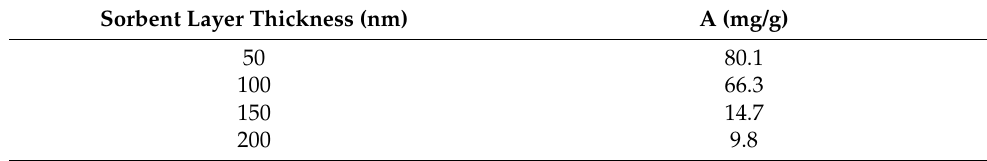
Figure 8. Dependence of adsorption capacity on thickness of aluminum oxide layer on biopolymer with pH value of solution. Table 2. Influence of sorbent layer thickness on sorption